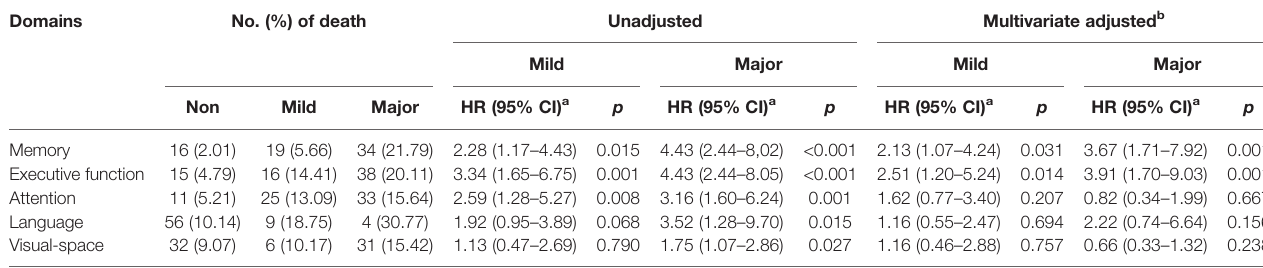
HR, hazard ratio; CI, con fi dence interval. a Hazard ratio from Cox proportional hazard regression analysis; the no-impairment group was used as the reference group. b Adjusted for age, gender, history of diabetes, hypertension, coronary heart disease and stroke, medication of ACEI/ARB, aspirin and insulin, body mass index, dialysis vintage, Kt/V, hemoglobin, serum levels of albumin, total cholesterol, triglycerides, calcium, phosphate, intact parathyroid hormone, C-reactive protein, beta2-microglobulin, eGFR, and fi ve domain cognitive